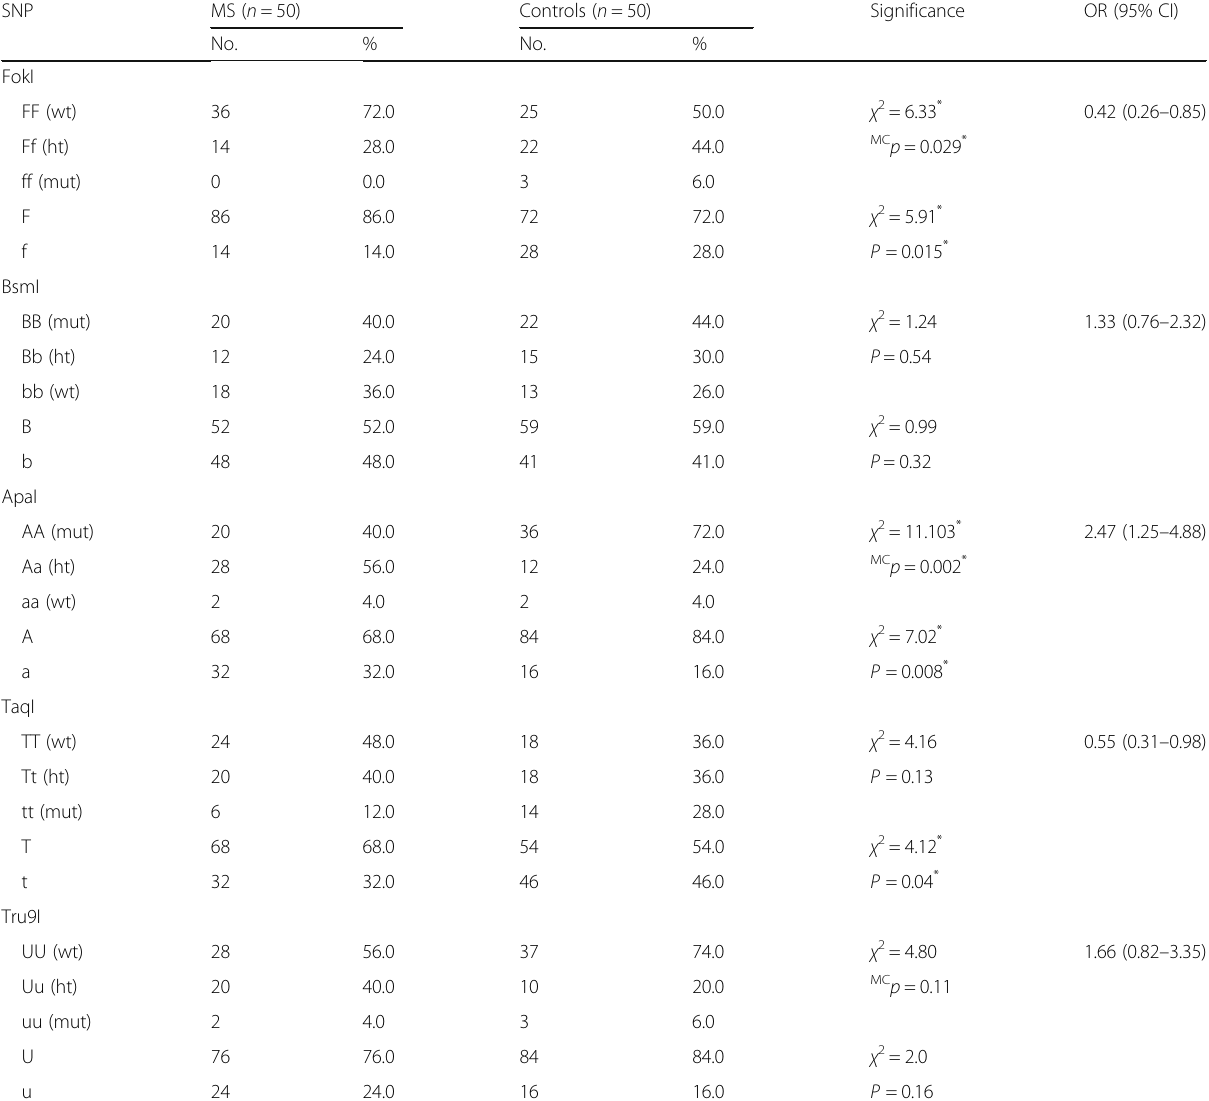
Table 2 VDR gene polymorphism genotype and allele frequencies in the two study groups